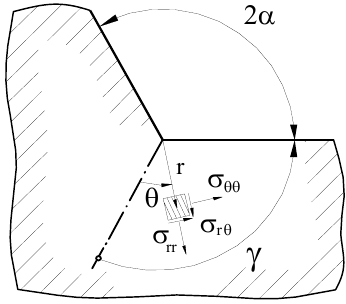
Figura 4. Sistema di coordinate polari centrato sull’apice